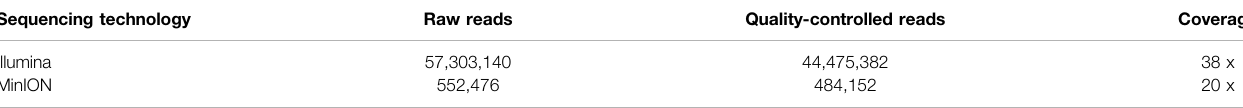
TABLE 1 | Summary of sequencing results.